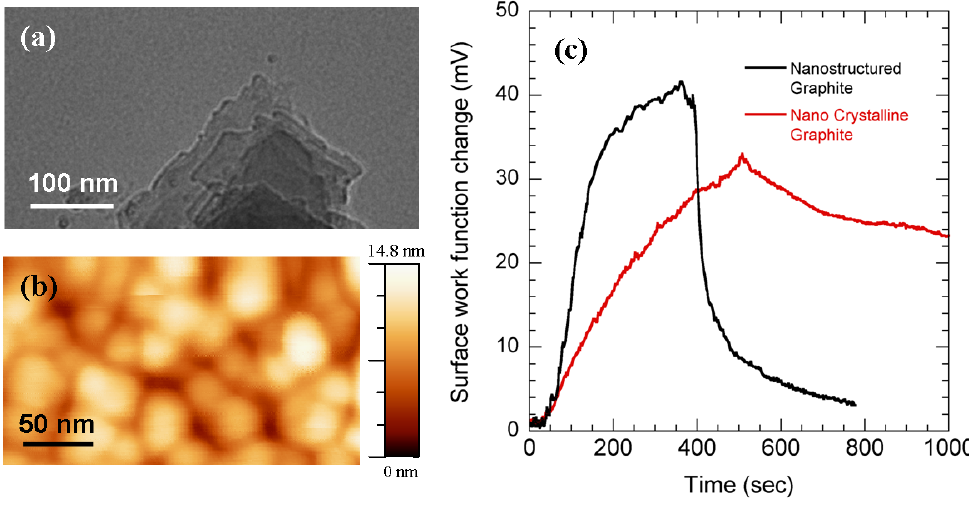
Figure 5: (a) TEM image of nanostructured graphite particles. (b) AFM morphological image of nanocrystalline graphite (c) Surface work function changes with the flow of 400 using nanocrystalline graphite (NCG) and nanostructured graphite (NG). NG ppb NO 2 shows higher sensitivity than